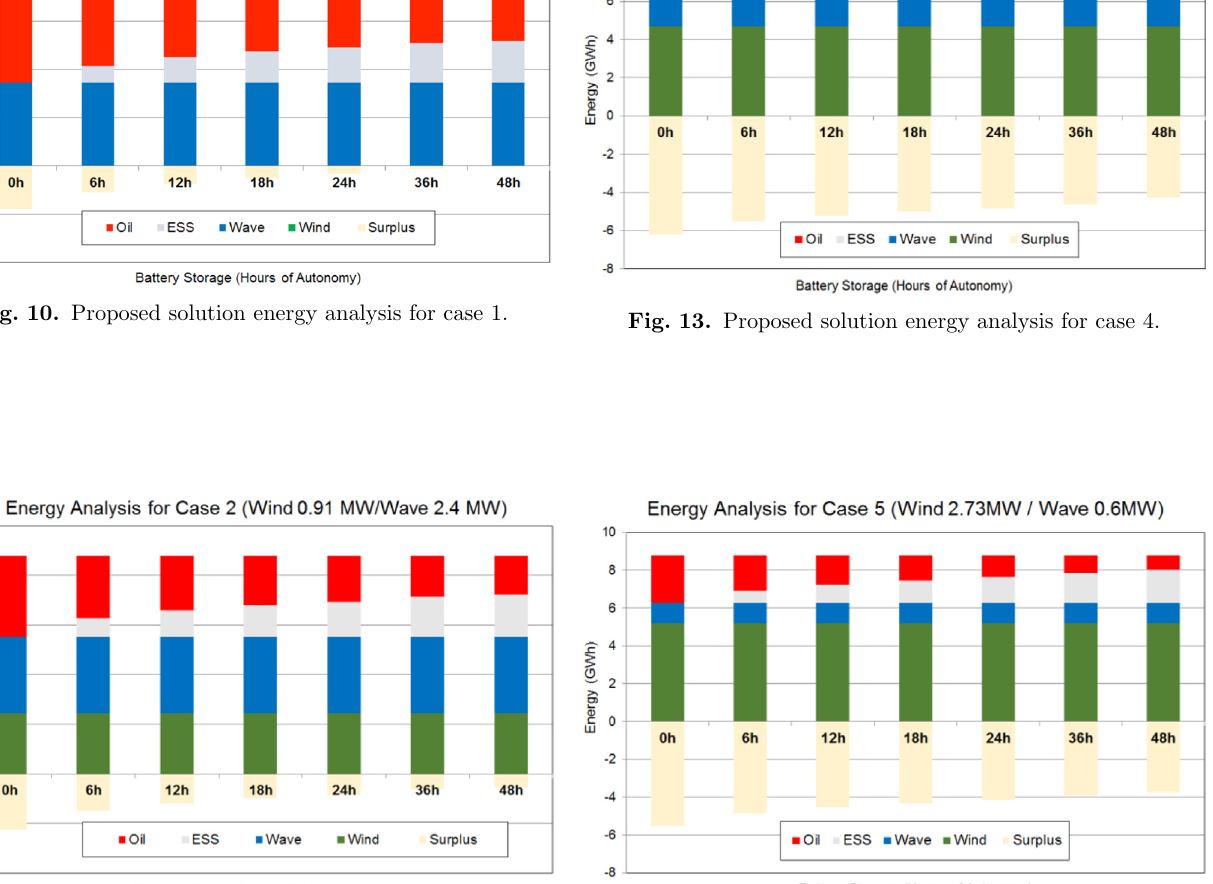
Fig. 11. Proposed solution energy analysis for case 2.